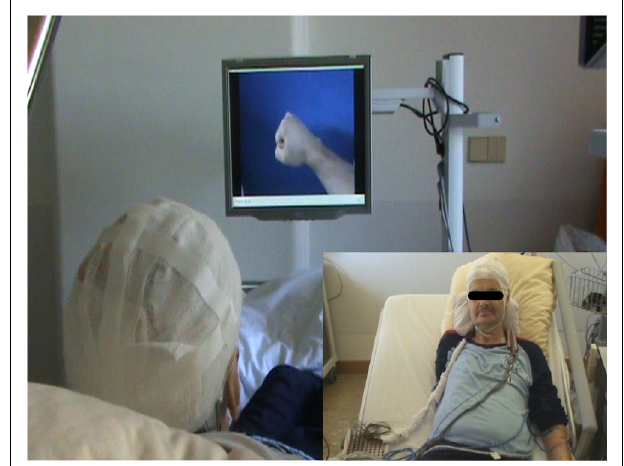
FIGURE 3 | Closed-loop brain–computer interface set-up. The implanted epidural neural interface for electrocorticographic (ECoG) recordings is externalized with percutaneous extensions connecting to the external components (see small inserted picture).The external components consist of a recording and processing unit and a feedback unit. Recording of ECoG signals is performed with a monopolar amplifier (BrainProducts, Munich, Germany) with a high-pass filter at 0.15 Hz and a sampling rate of 1000 Hz. Online processing of brain signals is performed with a BCI 2000 framework (Schalk etal., 2004) extended with custom-built features to control a video player via UDP. Feedback is provided according to phantom movement-related brain activity by a video player displaying a virtual hand prosthesis from the patient’s perspective (MinimalVideo Player, Phonon